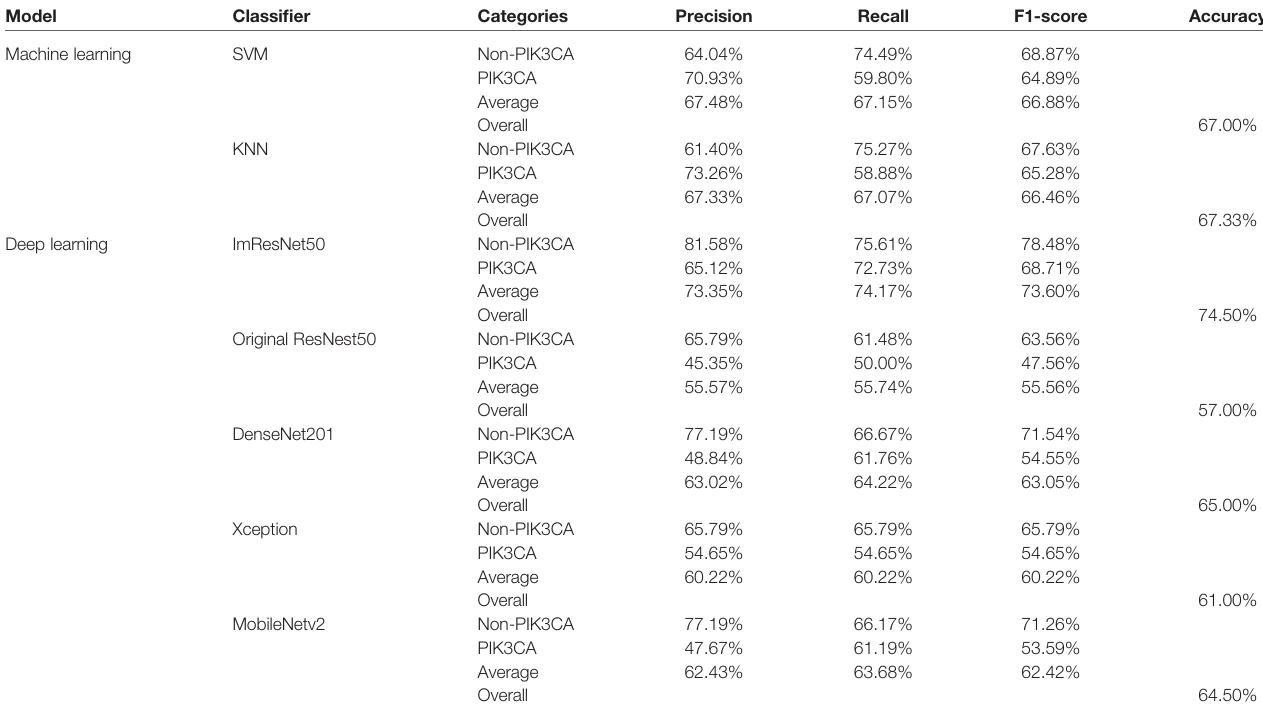
TABLE 1 | A performance summary of the ImResNet model and other models in identifying PIK3CA mutations of breast cancer.